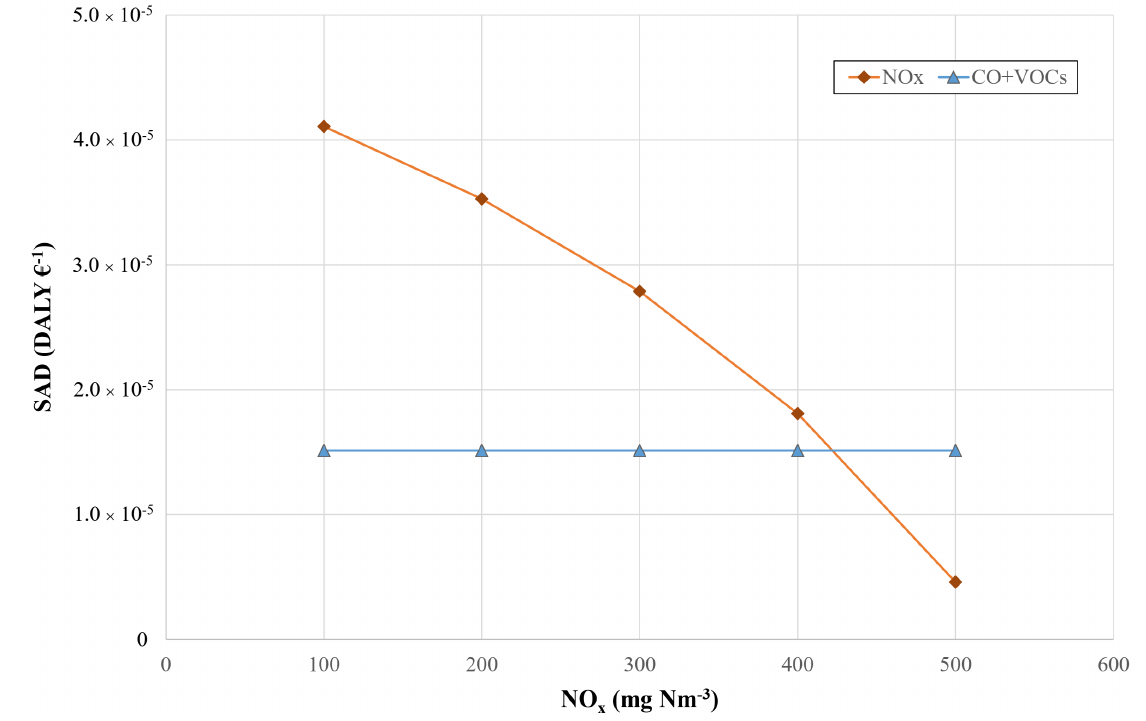
Figure 4. Trend of the SAD index (expressed in DALY e − 1 ) of the two devices as a function of the released NO x for the first scenario.